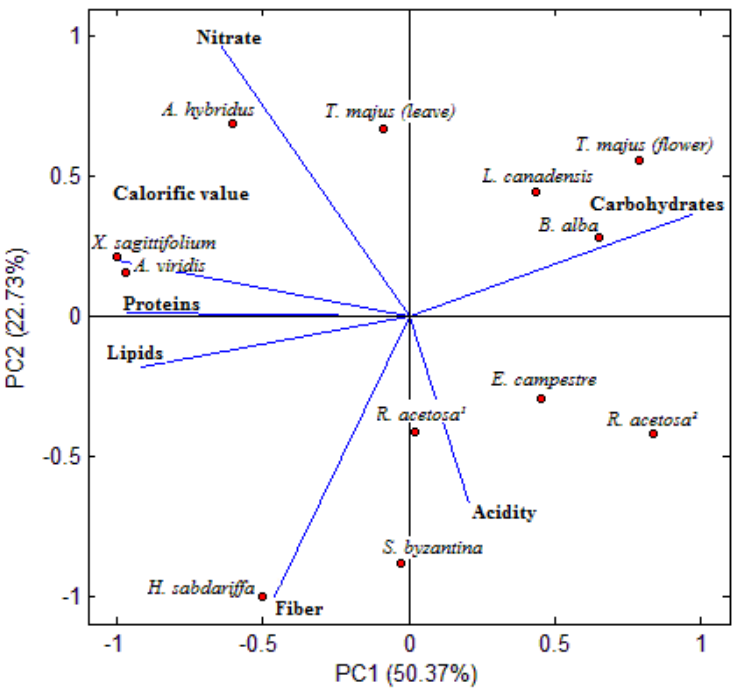
Figure 2 - Analysis of the main components related to the observed results for the levels of carbohydrate, acidity, fiber, lipids, proteins, calorific value and nitrate.